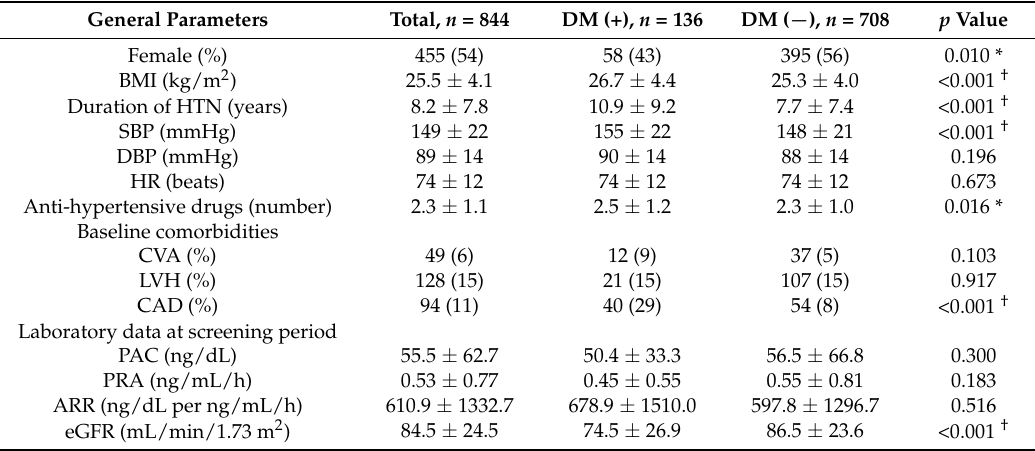
Table 1. Clinical characteristics of 844 PA patients with DM and without